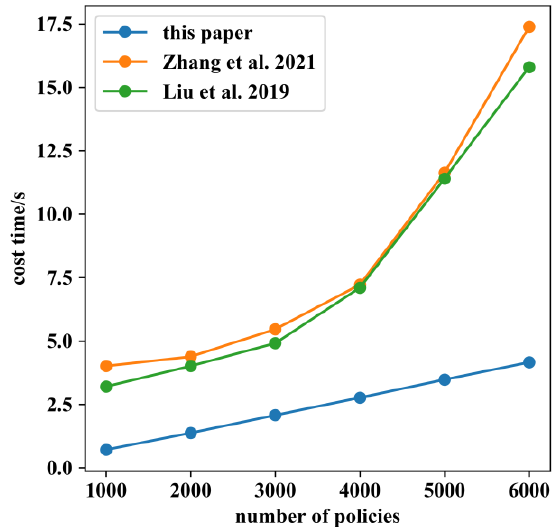
Figure 18. Effect of number of policies on time cost of access control process which compared with the results of the methods proposed by Zhang [18] and Liu [22]